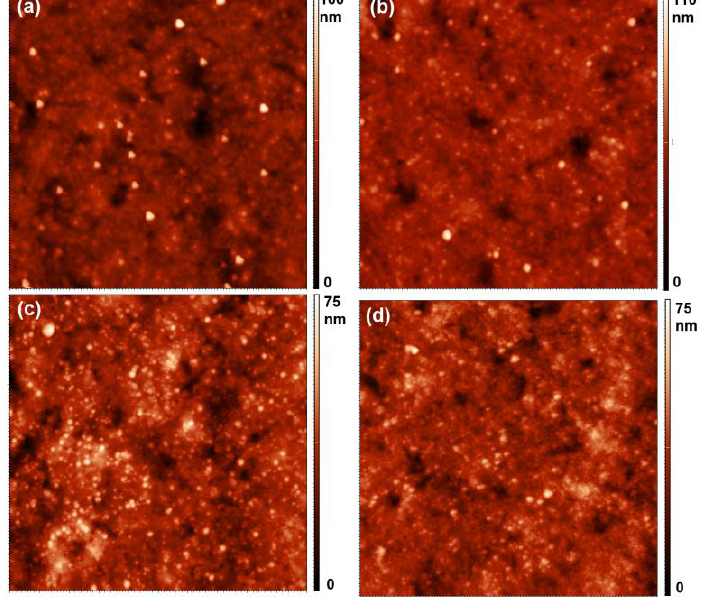
Figure 11. AFM images (5 × 5 µm 2 ) of selected samples: untreated ( a ) and treated at various fluences: ( b ) 0.1 × 10 22 m –2 ; ( c ) 82 × 10 22 m –2 ; and ( d ) 247 × 10 22 m –2.